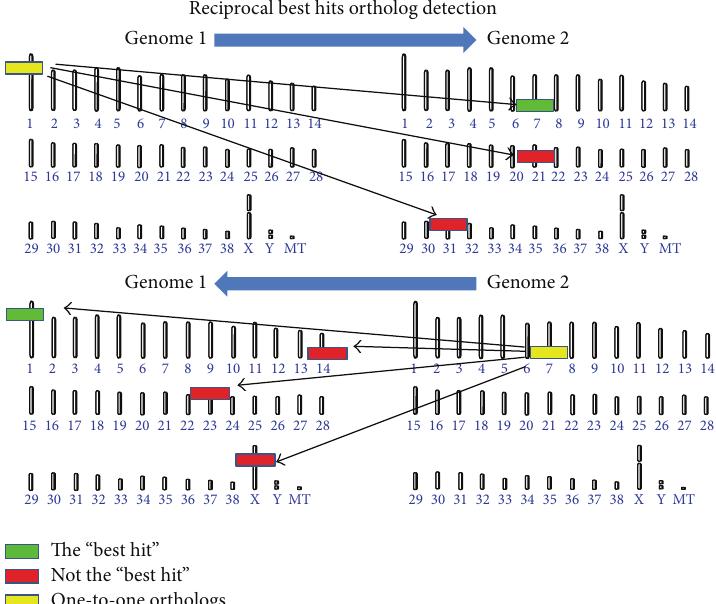
Figure 2: Identifying one-to-one orthologs between two genomes. The foundation of comparative genomics rests upon the ability to leverage annotation in a well-annotated genome in order to make inferences about genes in an undercharacterized genome. High sequence identity exists between orthologs (yellow genes, best hits) and paralogs (red genes, nonbest hits); however, paralogs are known to diverge in function much faster than orthologs. In order to achieve high confidence genotype-phenotype relationships via comparative genomics, it is essential to differentiate between orthologs and paralogs. Although complex relationships exist between orthologs, such as many-to-many and one-to- many/many-to-one, the most reliable annotation will be derived from one-to-one orthologs. The reciprocal best hit method for identifying orthologs successfully identifies one-to-one orthologs between two genomes if and only if the orthologs are the top hits to each.